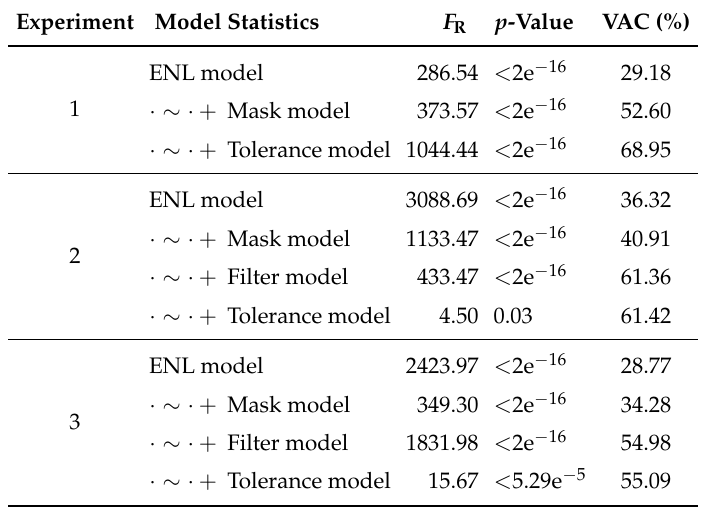
Table 4. Results of the robust linear regression modelling of the data in the four